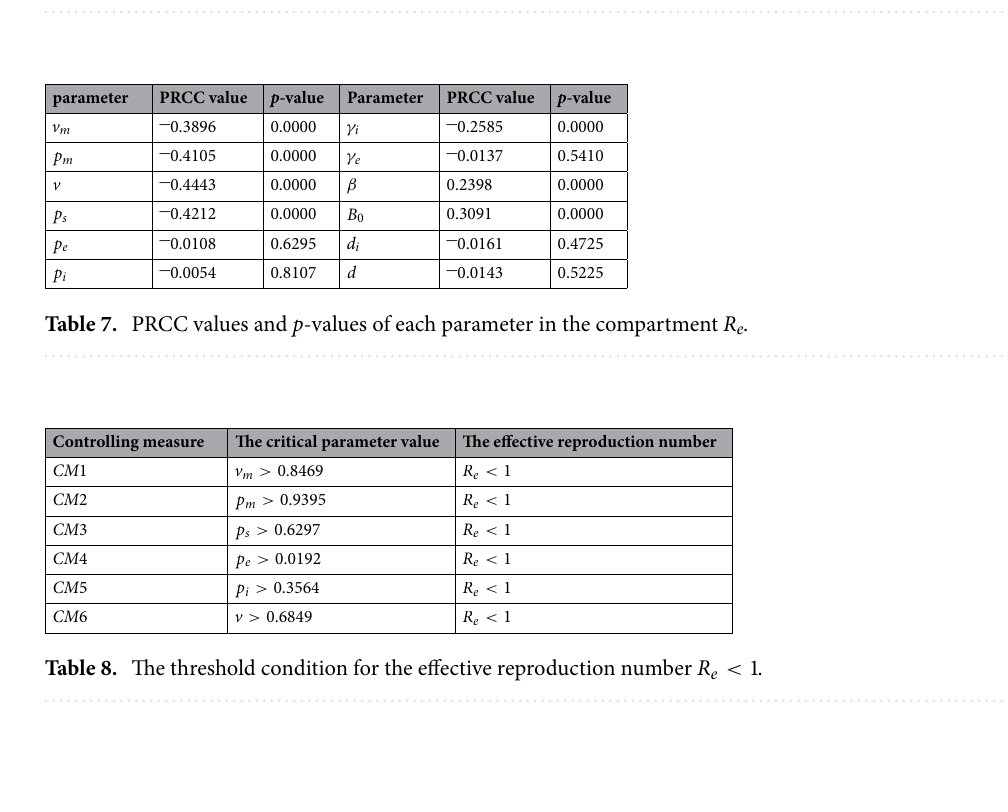
Table 6. PRCC values and p -values of each parameter in the compartment I ( t ).